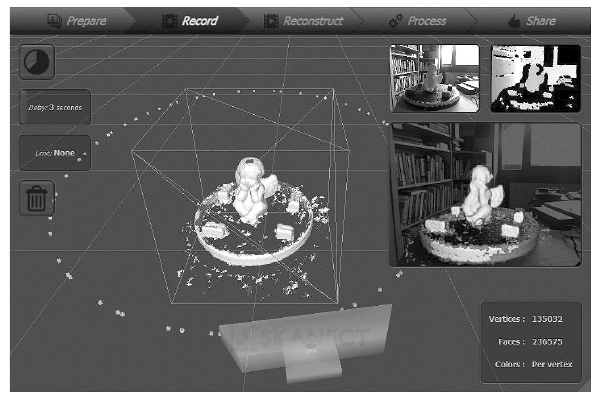
Figure 5: Skanect interface: 3D model, RGB and depth